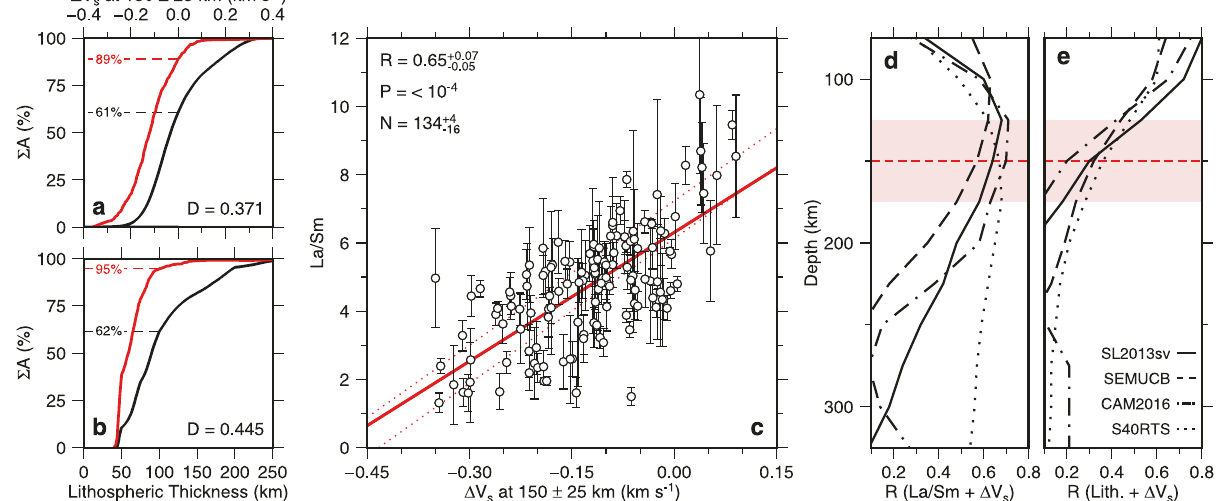
Fig. 2 Spatial and geochemical correlations. a Percentage cumulative area, Σ A , plotted as function of average value of Δ V s from SL2013sv tomographic model at depths of 150 ± 25 km where globe is subdivided into 1° bins weighted according to cos ϕ where ϕ = latitude in degrees; black curve = cumulative areal distribution of Δ V s ; red line = cumulative areal distribution of binned intraplate volcanic samples; black/red numbered dashed lines = percentages of global surface and of intraplate volcanism with Δ V s < 0 km s − 1 ; D = value of Kolmogorov – Smirnov statistic. Probability value of Kolmogorov – Smirnov test is p = 10 − 107 ( “ Methods ” ). b Σ A plotted as function of lithospheric thickness. Black/red lines = cumulative areal distribution of lithospheric thickness and of binned intraplate volcanic samples, respectively; black/red numbered dashed lines = percentages of global surface and of intraplate volcanism with lithosphere <100 km thick; D as before. Probability is p = 2 × 10 − 154 . c La/Sm plotted as function of average value of Δ V s at depths of 150 ± 25 km from SL2013sv tomographic model. Circles and error bars = average value ± σ for each 1° bin; red line = line that best fi ts values weighted according to cos ϕ ; pair of dotted red lines = uncertainty envelope for suite of best- fi t lines where Database 1 is binned using 99 different con fi gurations spaced at 0.1° intervals; R = correlation coef fi cient and its uncertainty; P = population correlation coef fi cient; N = number and range of bins. Note that Database 1 is screened to include only samples where 14.5 ≥ MgO wt% ≥ 9, <10 Ma, and number of samples per bin >5. d Value of R , calculated between La/Sm and Δ V = SL2013sv / CAM2016Vsv / SEMUCB- s , plotted as function of depth for four different tomographic models. Solid/dash-dot/dashed/dotted lines WM1 / S40RTS tomographic models 19,21,22,34 ; R = 0.28 is minimum value of R distinguishable from zero at signi fi cance level of = 0.001. Red dashed line with shaded rectangle = 150 ± 25 km for reference. e Value of R , calculated between lithospheric thickness and Δ V s , plotted as function of depth as